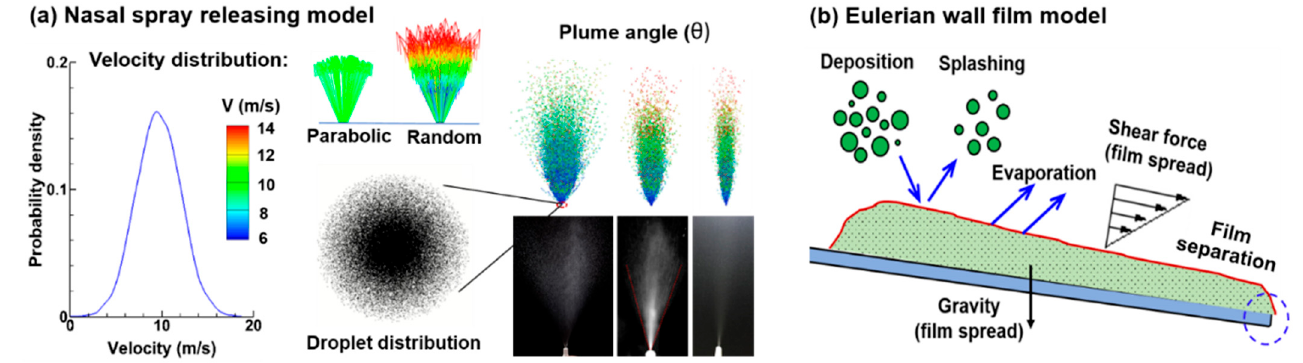
Figure 3. Computational models: ( a ) spray releasing model with prescribed droplet velocity and droplet distributions (normal distributions herein), and varying spray plume angles and ( b ) Eulerian wall film model considering droplet deposition, splashing, stripping, film separation, and film migration due to shear and gravity.